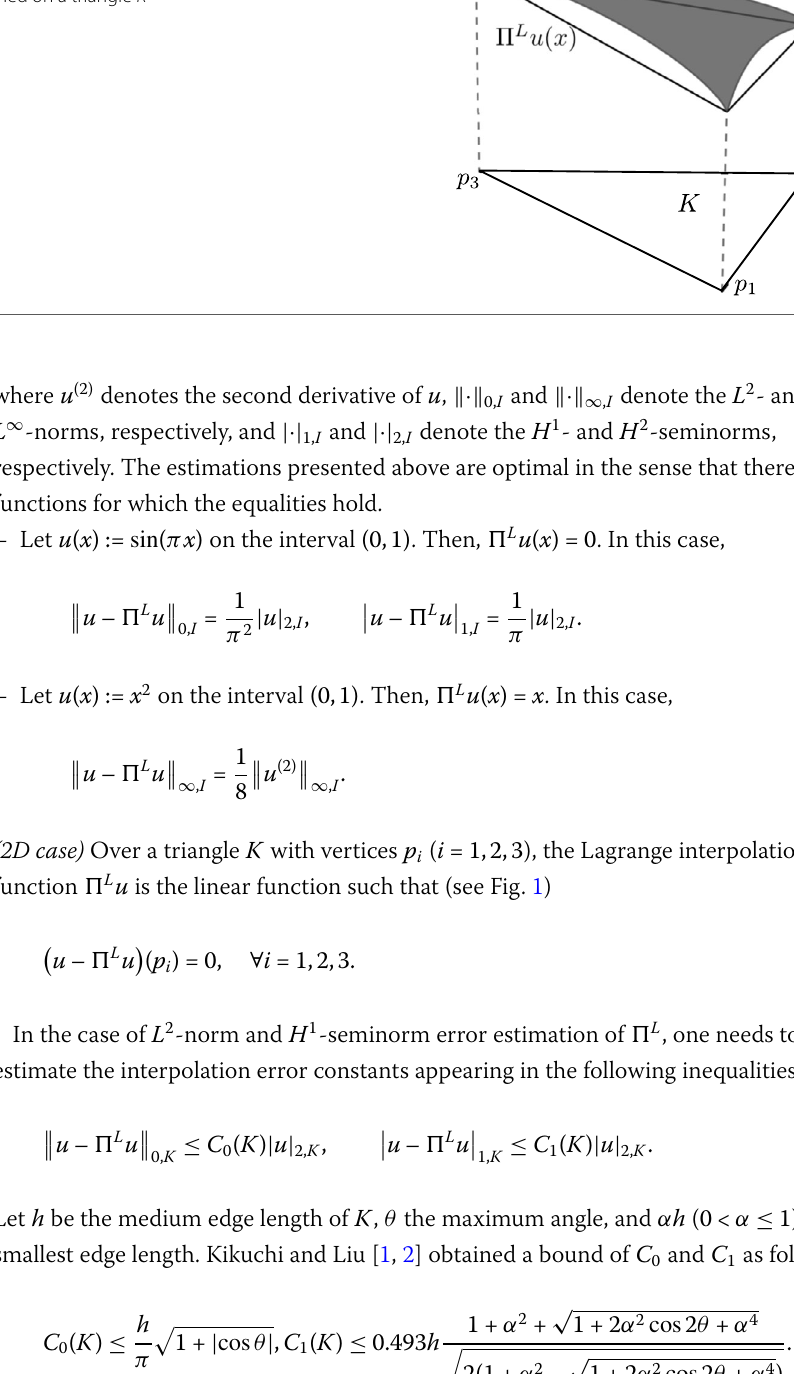
Figure 1 A linear Lagrange interpolation function (cid:2) L u defined on a triangle